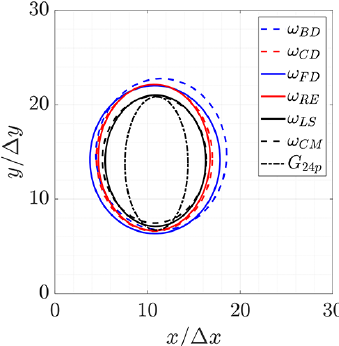
Figure 12. Jittering zones over the area of interest with Graftieaux and vorticity VIMs.